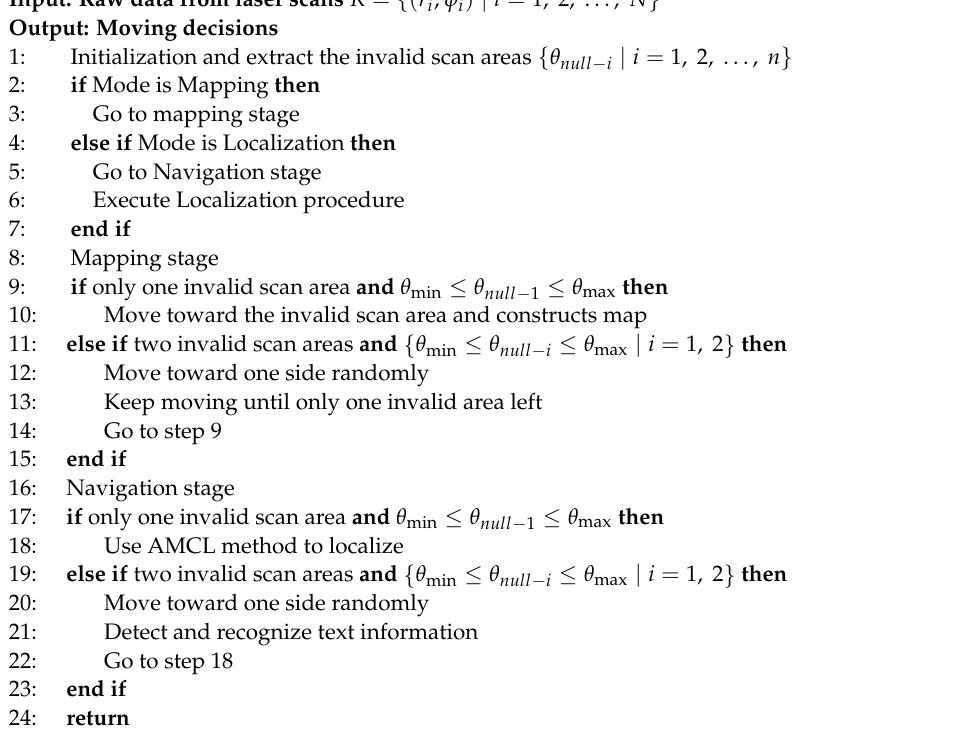
Algorithm 1. Autonomous Moving